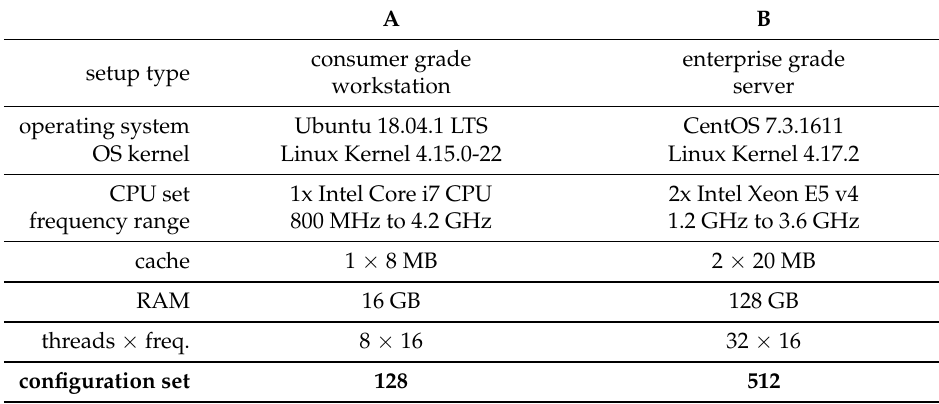
Table 2. Software & Hardware